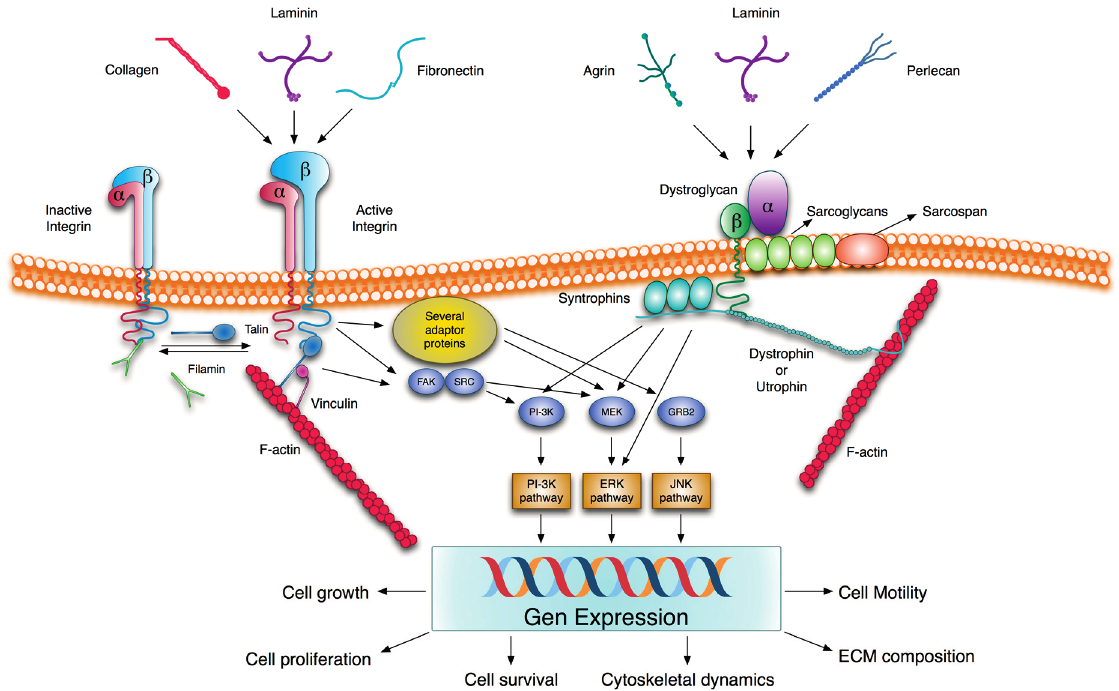
Figure 2. Integrin- and dystroglycan-mediated ECM signaling. Several ECM components are able to interact with integrins and dystroglycans. Unlike dystroglycan, integrins